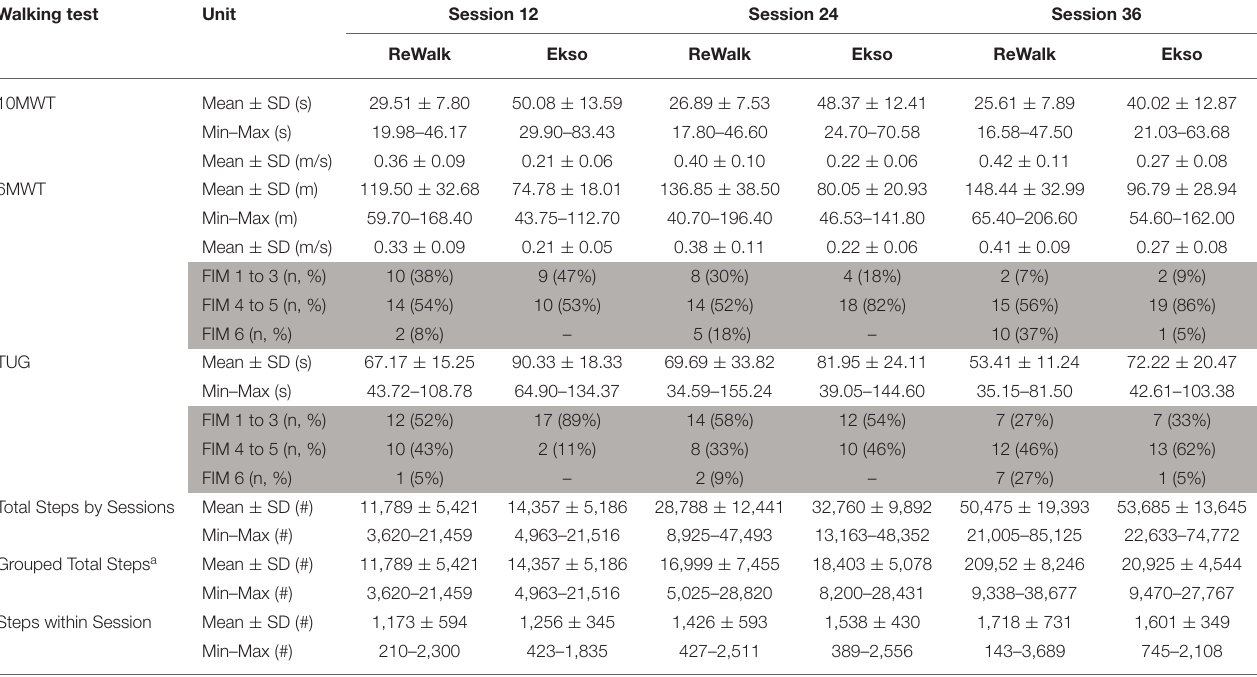
TABLE 4 | Walking test results by devices (ReWalk and Ekso). Walking test Unit Session 12